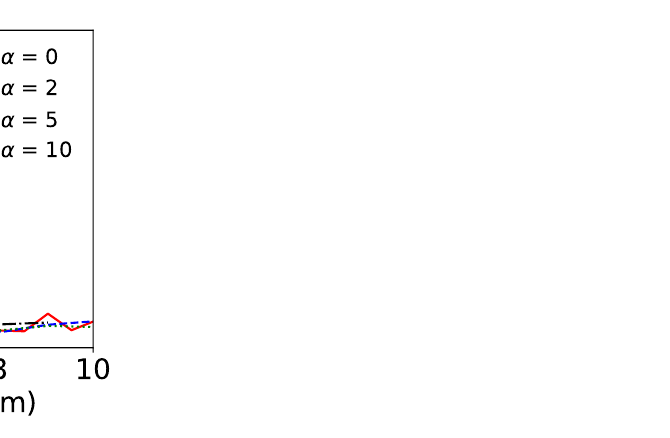
Figure 9. Influence of the skew-normal (SN) transverse beam density profile. ( a ) The 1D density profile in the x -direction at injection. α is the form parameter of the SN distributions. ˜ µ 3,0 and h 0 is the skewness and kurtosis. ( b ) Evolution of the normalized transverse emittance (cid:101) n . ( c ) Evolution of the skewness of the x -direction beam density profile. Data points are sampled per